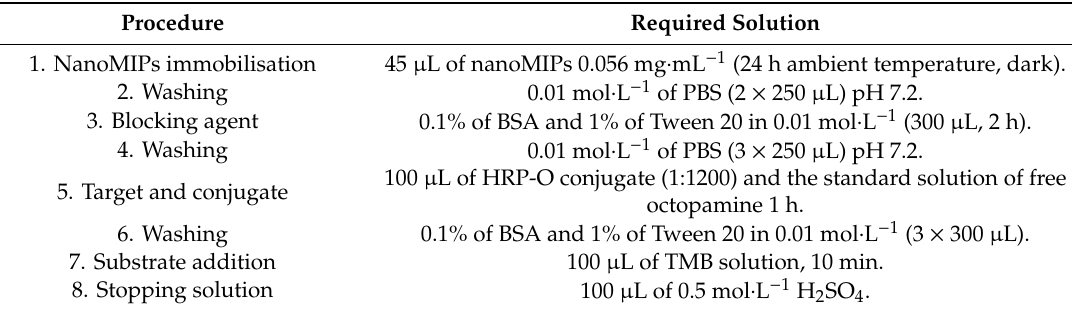
Table 1. Standard procedure for competitive